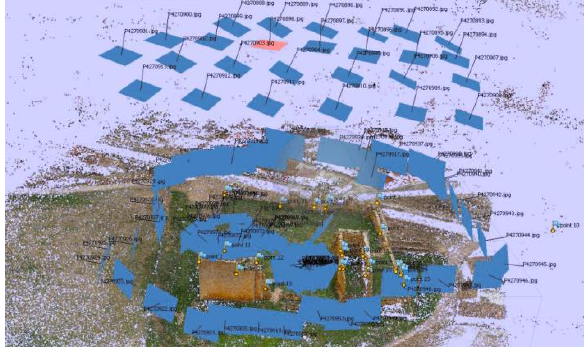
Figure 3: Position of information captures based on images over the cloud of correspondence dots.